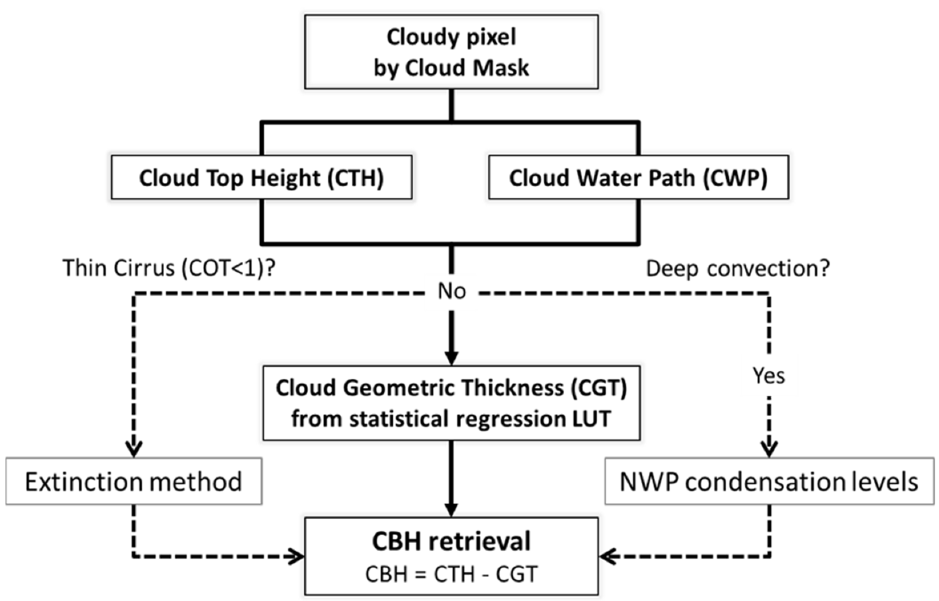
Figure 2. A schematic diagram of the statistical CBH algorithm for single-layer clouds (modified from Noh et al. [50]).